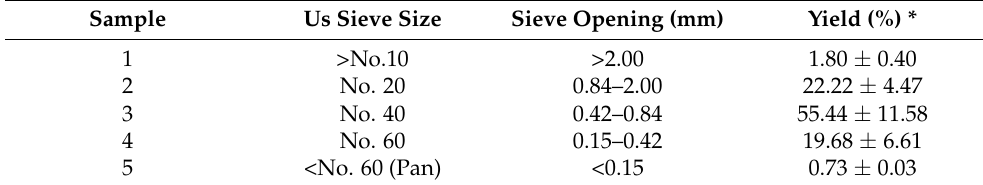
Table 1. Yield of different fractions of DDGS in sieving operation.